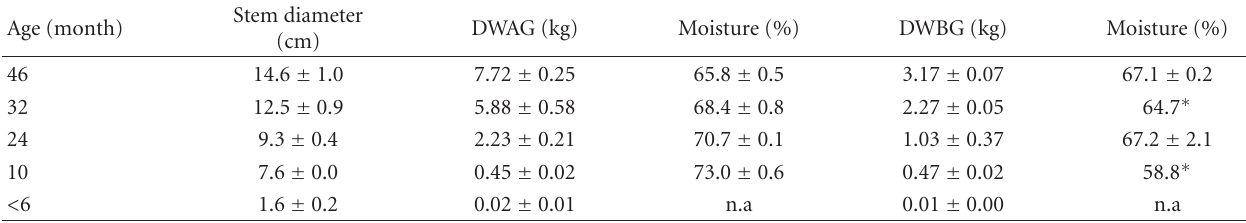
Table 1: Mean ± standard error of stem diameter, dry weight of the aboveground and belowground section of Jatropha curcas, and its moisture content at di ff erent